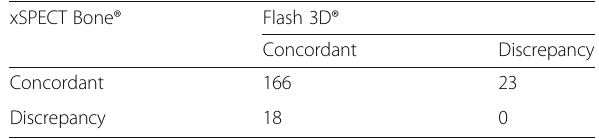
Table 2 Categorical classification of the diagnosis